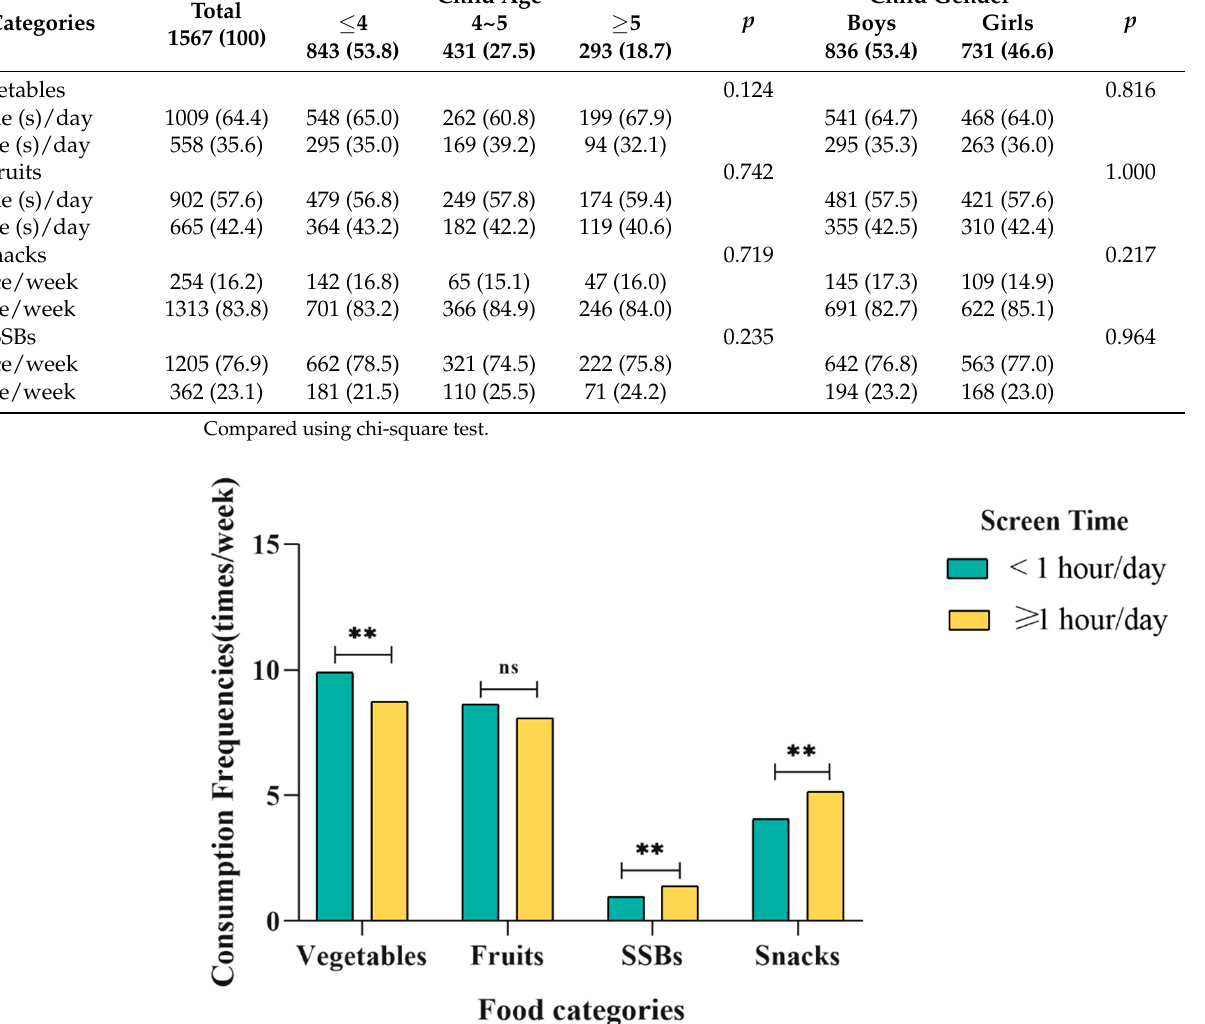
Figure 2. The distribution of consumption frequencies of vegetables, fruits, SSBs and snacks by screen time among preschool children. (times/week). ** p < 0.01, ns means no statistically significant, p ≥ 0.05.